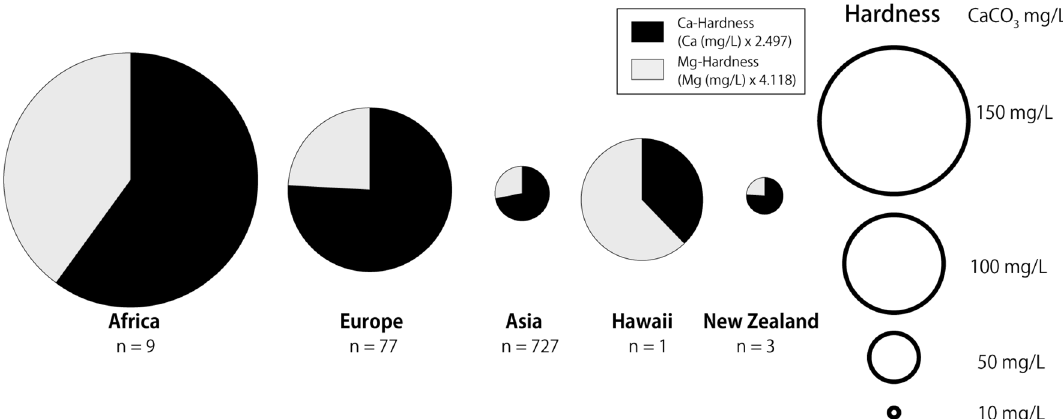
Figure 1. Graphic distribution of tap water hardness and the proportion of Ca and Mg-hardness by study area. The area of circles is proportional to hardness. n the number of samples.